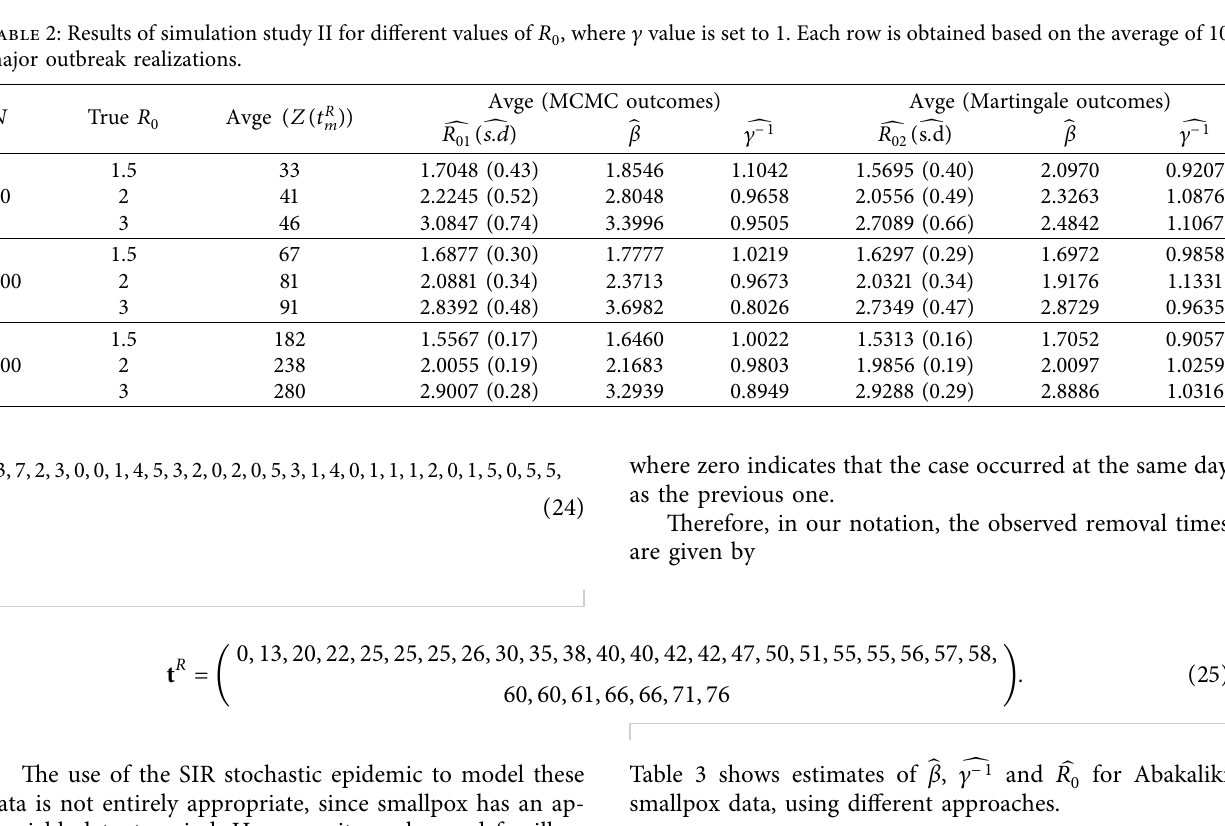
� 2 . 5, β � 2 . 5, and c � 1. Each row is obtained based on the average of 1000 major outbreak 02